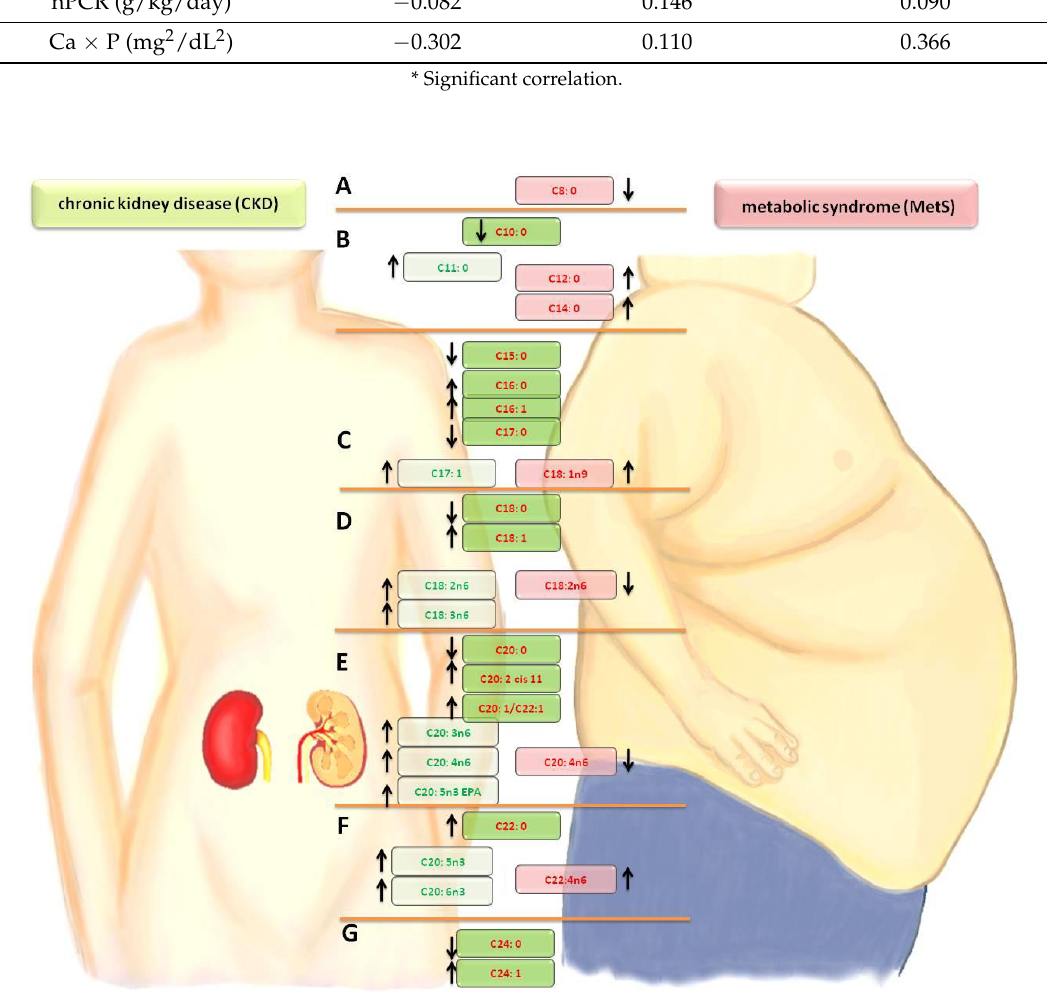
Figure 1. Comparison of changes in the fatty acid profiles in the CKD and MetS groups. A— lowering short-chain FA. B—saturated fatty acid (SFA) elongation. C—mono-unsaturated fatty acid (MUFA) growth at the expense of SFA/palmitic acid derivatives. D—stearic acid derivatives/synthesis of the n-6 family in CKD. E—cascade of arachidonic acid/synthesis of the n-3 and n-6 families. F—increased synthesis of the n-3 and n-6 families. G—synthesis of nervous acid.